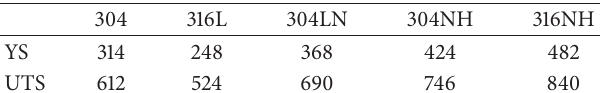
Table 3: Yield strength and ultimate tensile strength in MPa of the stainless steel specimens at room temperature.